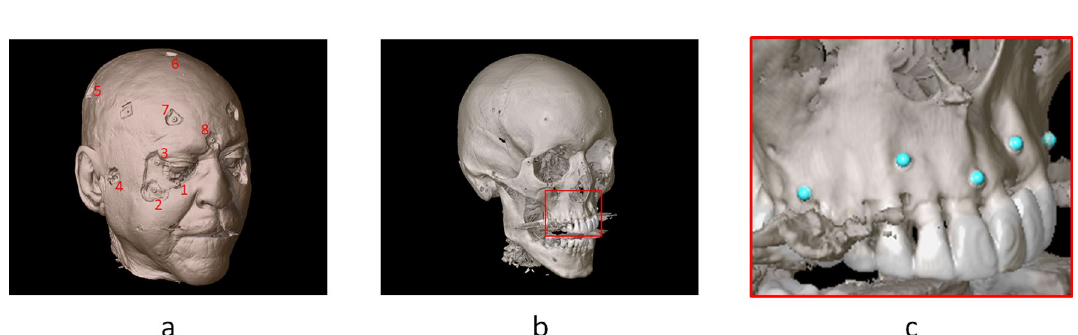
Figure 1. Cadaver model. The numbers at the Allen screw positions ( a ) correspond to the anatomic landmarks provided in Table 1. In ( b ), the titanium screws in the maxilla are visualized; in ( c ), the registration points have been indicated in the screw